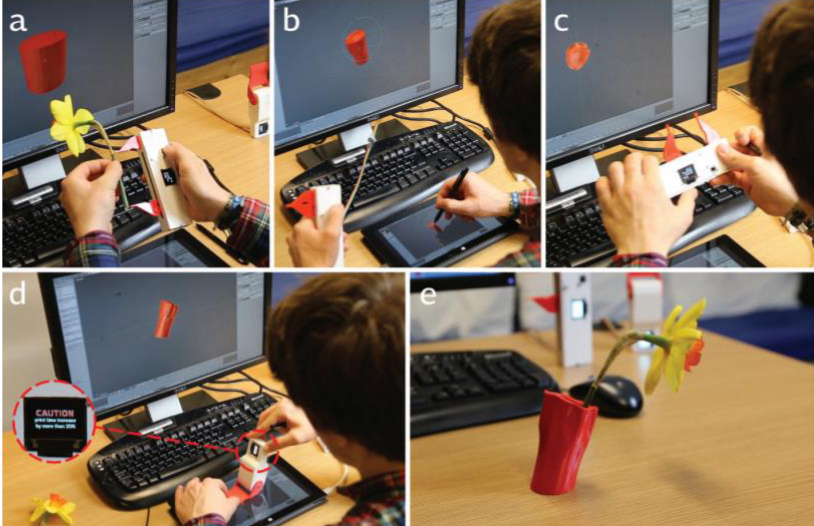
Figure 35. ( a ) creation of vase by using SPATA tools, ( b ) sculpting decorative features by SPATA tools, ( c ) checking the size of the model, ( d ) exploring flower hole angles, ( e ) printed object